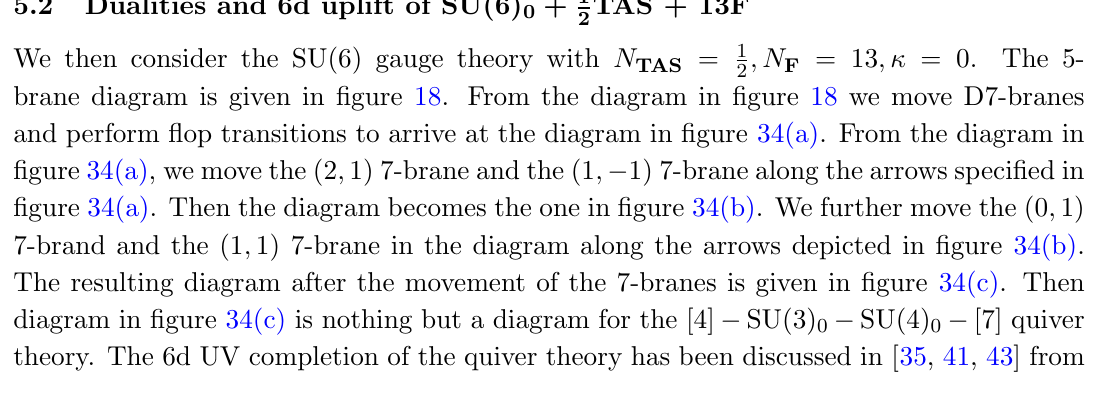
Figure 34 . (a) A 5-brane web diagram for the SU(6) gauge theory with N TAS = 1 0. (b) The diagram after moving the (2 ; (cid:0) 1) 7-brane and the (1 ; 1) 7-brane along the arrows in (cid:12)gure 34(a). (c) A 5-brane diagram for the [4] (cid:0) SU(3) 0 (cid:0) SU(4) 0 (cid:0) [7] quiver theory which